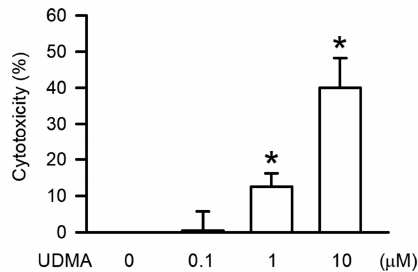
Figure 1. Urethane dimethacrylate (UDMA) induced cytotoxicity in RAW264.7 macrophages. The cells were incubated with UDMA at concentrations of 0, 1, 10, and 100 μ M for 24 h at 37 °C. Cytotoxicity was measured using the LDH assay. Data are expressed as mean ± SD (n = 5). *P < 0.05 is considered significant compared with the control group.